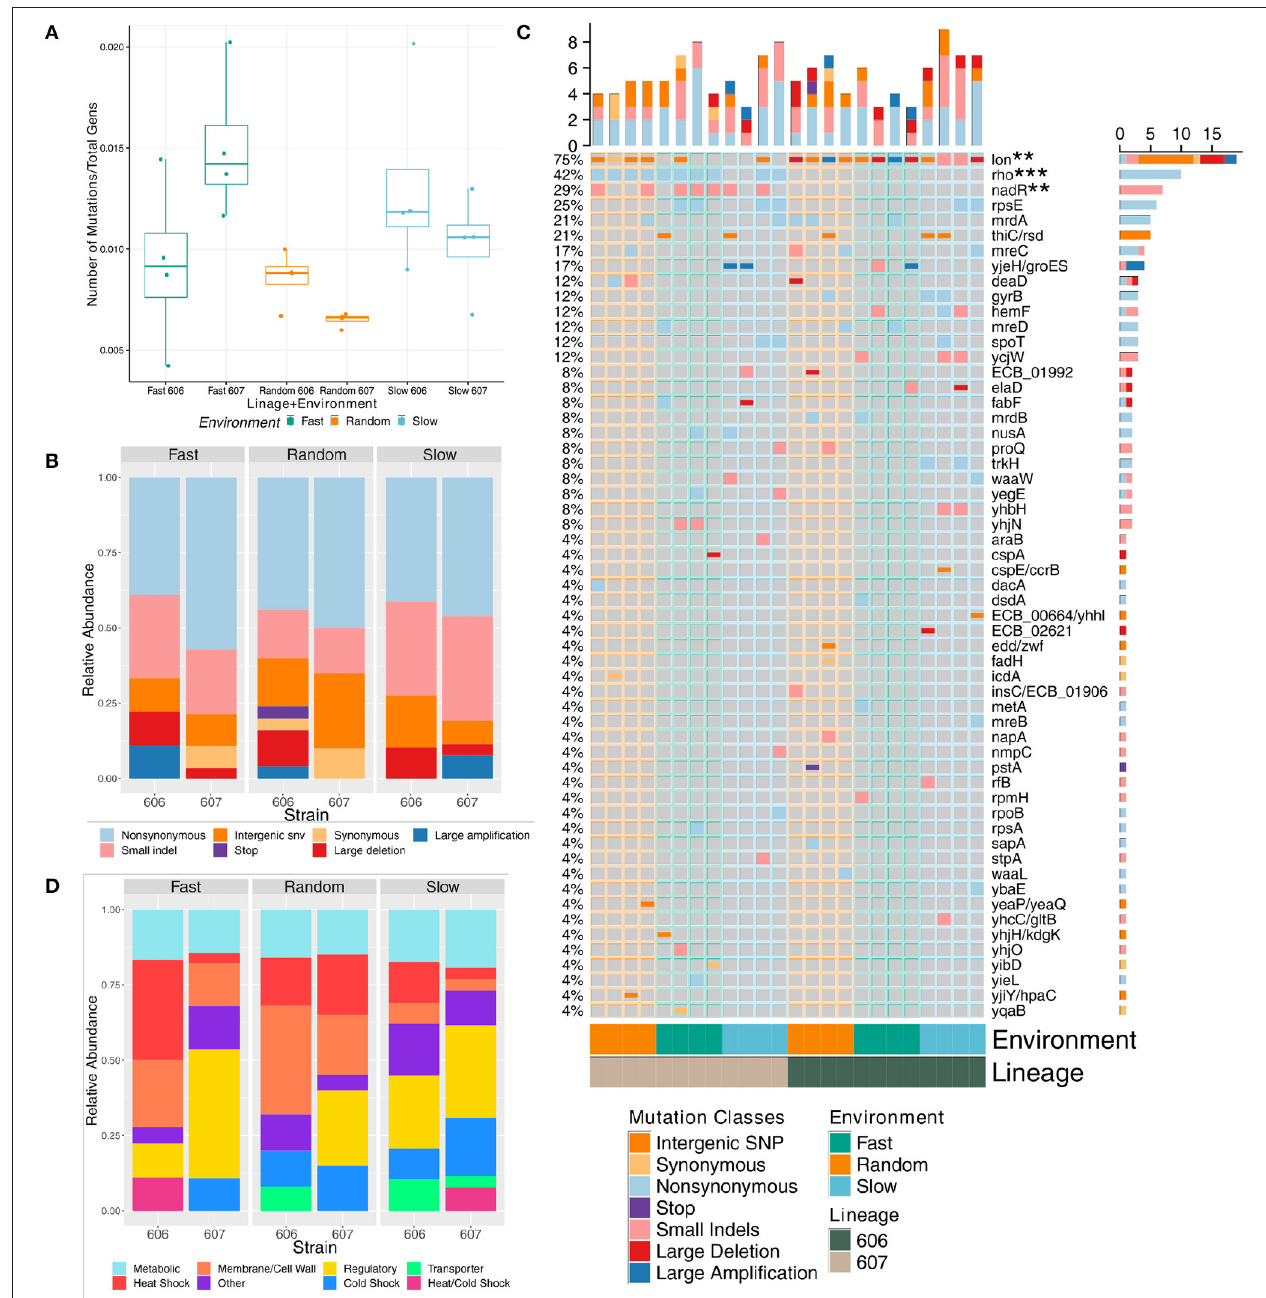
FIGURE 3 | Mutational composition of the final evolved strains’ population sequencing data evolved under fluctuating temperatures (note, mutations with frequency of 5% or greater in a final sequenced population are considered). (A) Boxplot showing the comparison of the total number of mutations normalized to total number of generations at the final time-point by strain and fluctuation regime. (B) Relative frequency of each mutation by class at the final time-point by strain and fluctuation regime. (C) Mutation incidence matrix of the population data. Mutations are coarse grained at the gene level. Large deletions and amplifications are counted once and collapsed to the repeatable gene. We use the Z-score to test significance of mutation enrichment between the evolved 606 lineage vs 607 lineage strains for genes that had mutations in three or more strains, and nadR and rho mutations were significantly enriched for the 607 lineage evolved strains ( p -value = 0.017 with FDR = 0.08, and p -value = 0.00014 with FDR = 0.002, respectively). The mutation enrichment for periodic vs. random fluctuation regimes were assessed in the same manner with deaD enriched in random strains ( p -value = 0.028, FDR = 0.0977) and lon enriched in periodic 606 evolved strains ( p -value = 0.0015, FDR = 0.010). (D) Relative frequency of each mutation grouped by functional category at the final time-point by strain and fluctuation regime.